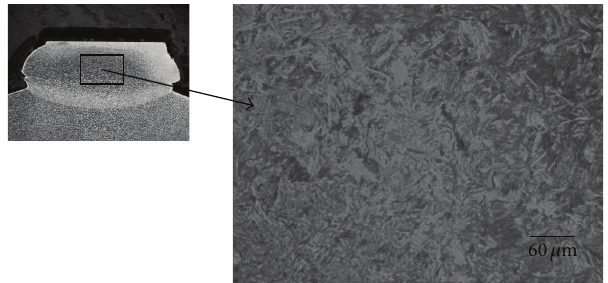
Figure 12: Microstructure of the central region of weld metal corresponding to part of the end-plate ( × 500).